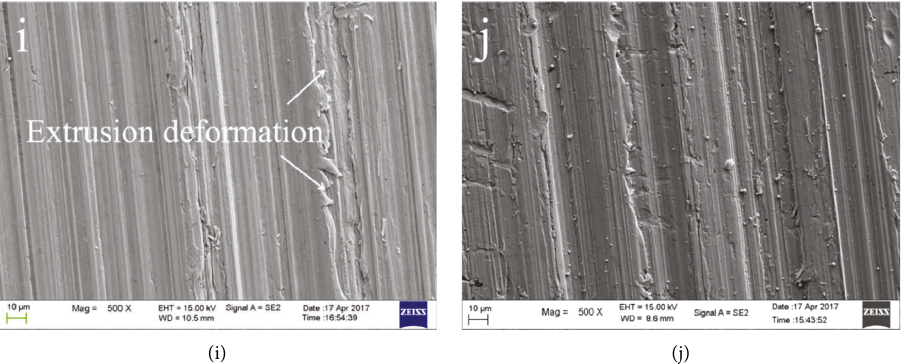
Figure 7: Worn morphologies of the wear scars lubricated with base fluid (a-e) and nanofluid (f-j) under different surface roughness: (a), (f)